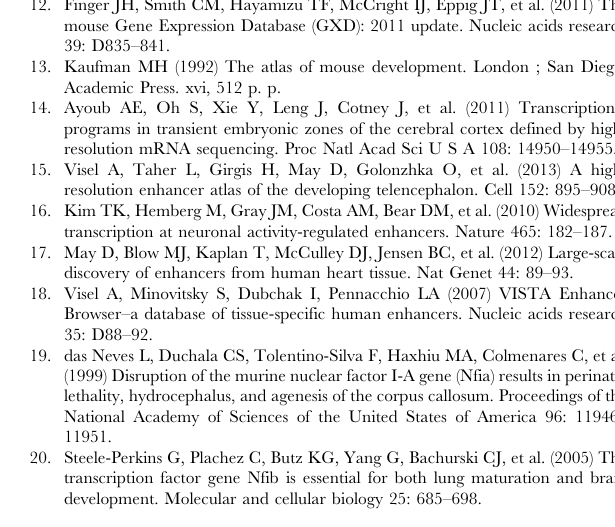
Figure S2 All whole mounts of transgenic embryos for enhancer elt2 (Figure 2B), near Satb2 . (TIFF) Figure S3 All whole mounts of transgenic embryos for enhancer elt3 (Figure 2C), near Neurod2 . (TIFF) Figure S4 All whole mounts of transgenic embryos for enhancer elt4 (Figure 2D), near Tbr1 . (TIFF) Figure S5 All whole mounts of transgenic embryos for enhancer elt5 (Figure 2E), near Auts2 . (TIFF) Figure S6 All whole mounts of transgenic embryos for enhancer elt6 (Figure 2F), near Id4 . (TIFF) Figure S7 All whole mounts of transgenic embryos for enhancer elt7 (Figure 2G), near Bhlhb5 . (TIFF) Figure S8 All whole mounts of transgenic embryos for enhancer elt8 (Figure 2H), near Auts2 . (TIFF) Table S1 The mouse mm9 coordinates of 6,629 p300 peaks obtained from E14.5 dorsal cerebral wall ChIP-seq. (XLSX) Table S2 PCR primers used to clone candidate enhancer elements from mouse genomic DNA. 5 9 -CACC’’ was added to each left primer for cloning into